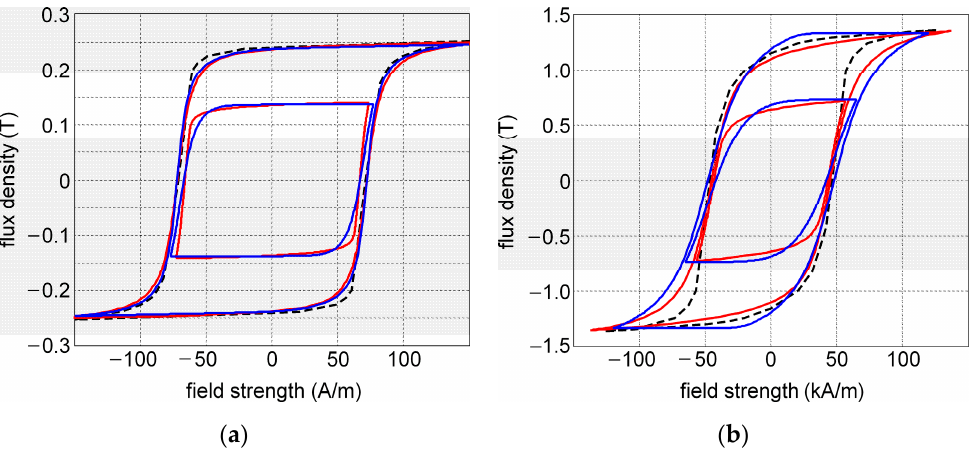
Figure 13. Hysteresis loop of ( a ) Mn-Mg ferrite [50], ( b ) ferromagnetic material ЮН 14 Д K24; measured loops—black lines,